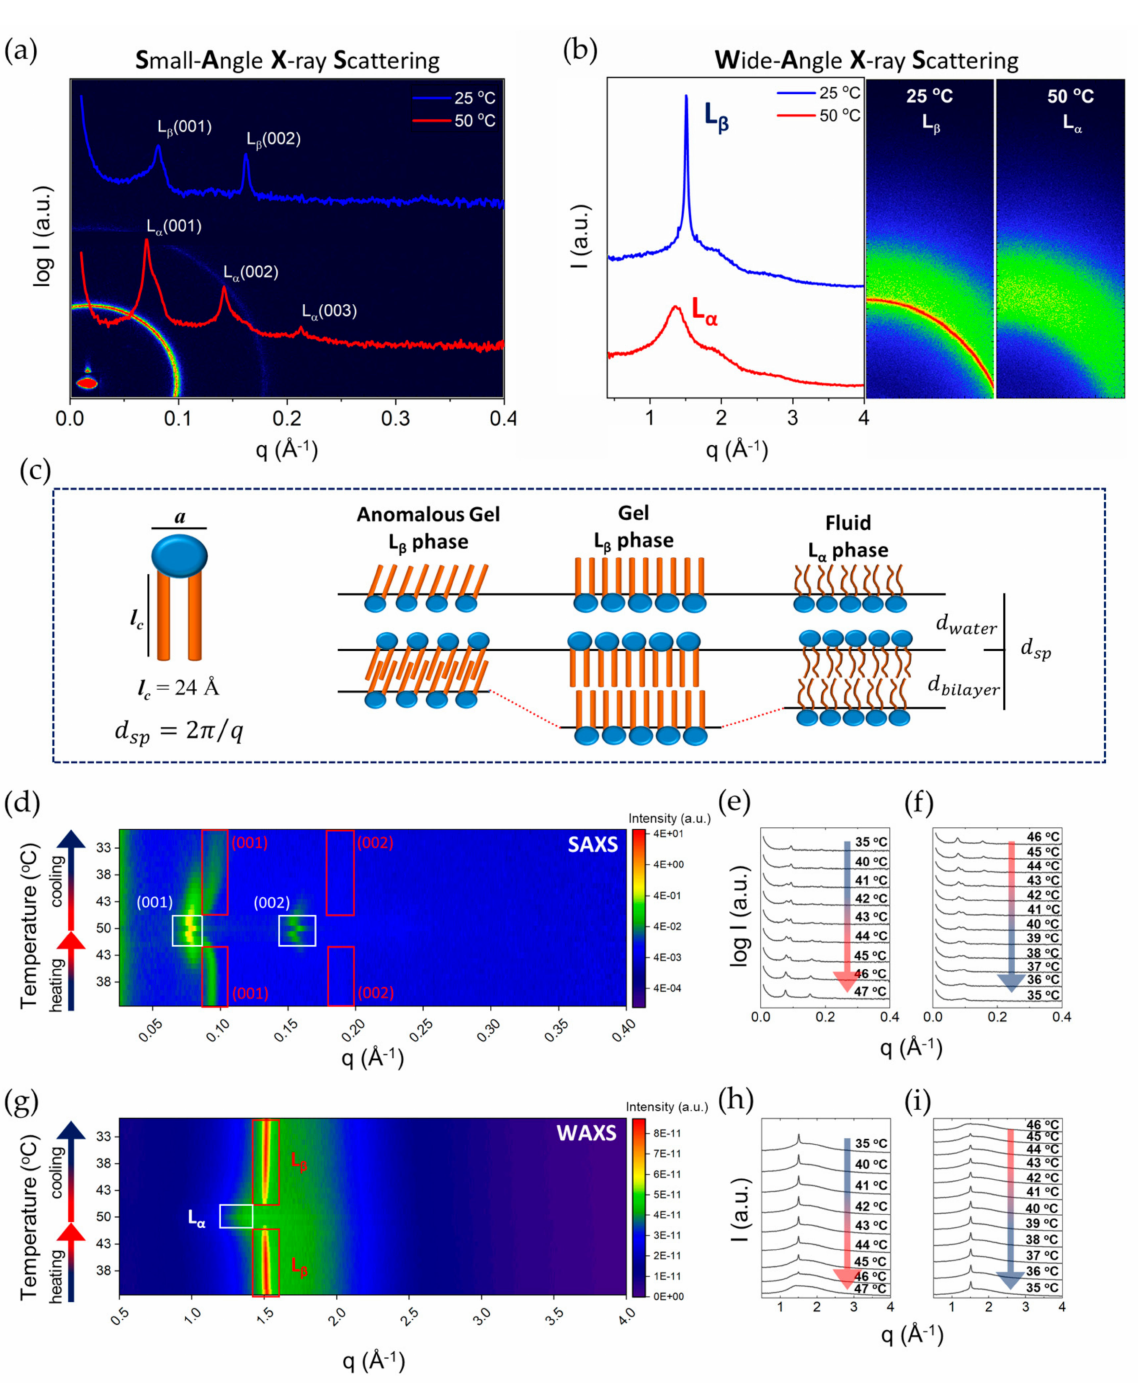
Figure 2. Small- and wide-angle X-ray scattering characterisation of 35 wt% DODAC in water. ( a ) SAXS and ( b ) WAXS at a temperature below (25 ◦ C) and above (50 ◦ C) the T m . ( c ) Schematic representation of various lamellar phases. a—area per surfactant molecule, l c —hydrocarbon chain length, d sp —interlamellar spacing. ( d ) 2D image and corresponding ( e , f ) 1D SAXS patterns and ( g ) 2D image and corresponding ( h , i ) 1D WAXS patterns during a heating and cooling ramp from 35 to 50 ◦ C, and back to 35 ◦ C. L β corresponds to the gel phase and L α to the liquid crystalline